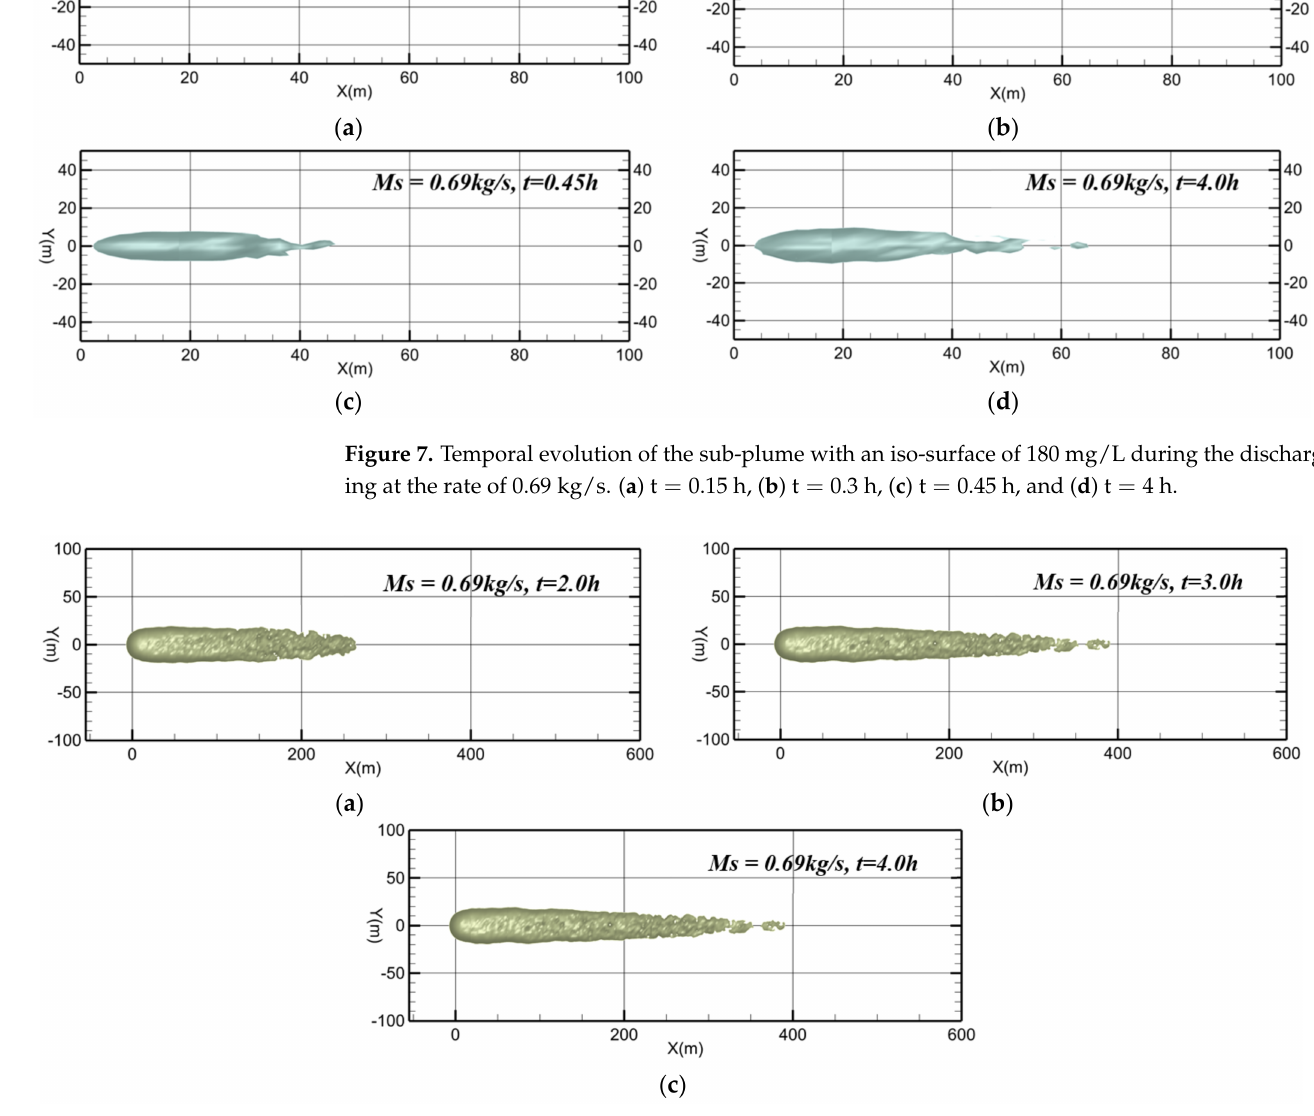
Figure 8. Evolution of the sediment sub-plume with an iso-surface of 63 mg/L during the discharging at the rate of 0.69 kg /s. ( a ) t = 2 h, ( b ) t = 3 h, ( c ) t = 4